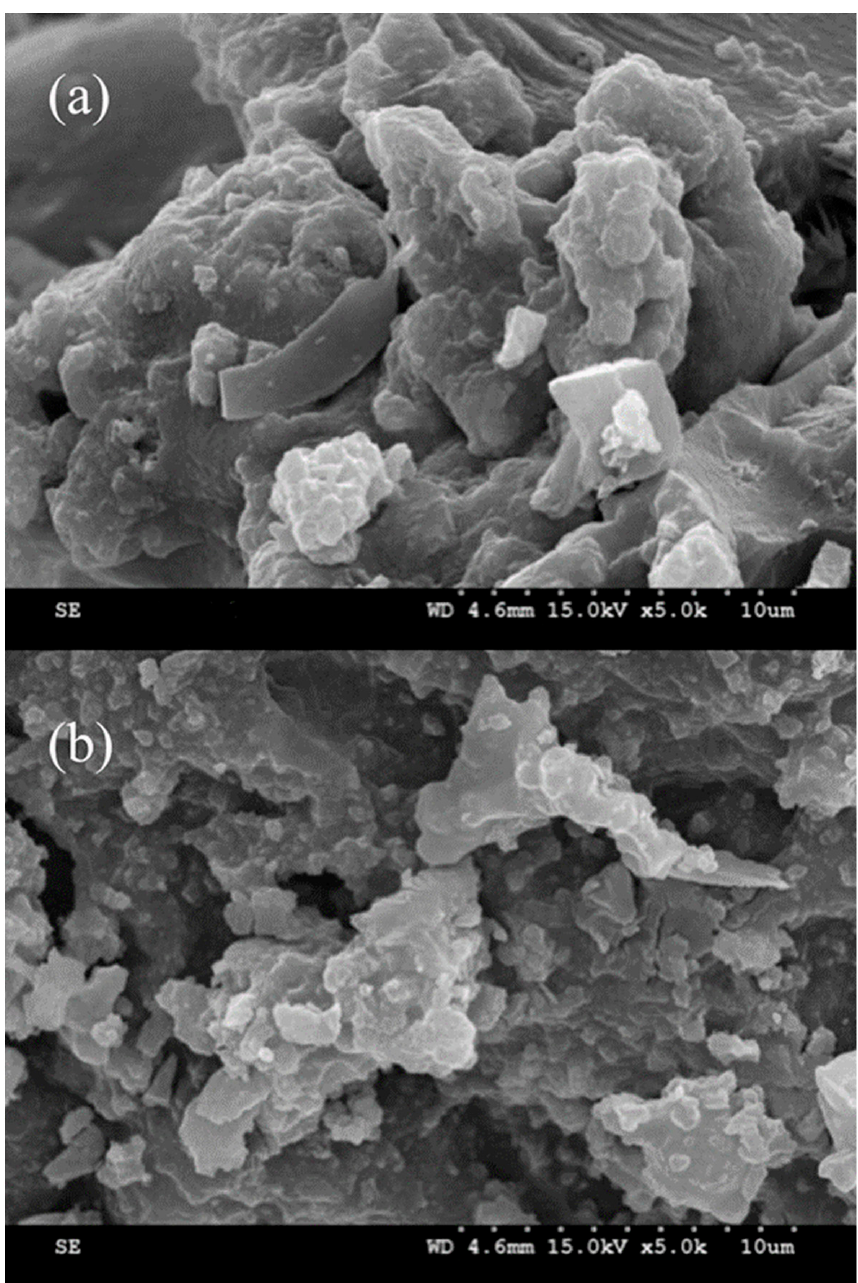
Figure 3. SEM images of the MNICM ( a ) and MMICM ( b ). TGA characterization of the MNICM and MMICM was also carried out, as shown in Figure S2. As can be seen, a first mass loss event was tested in the MMICM below 200 ◦ C, and in the MNICM at temperatures below 100 ◦ C, which corresponds to the evaporation of moisture. Then, MNICM started to lose weight significantly at around 100 ◦ C, and stabilized at 18.2% at 400 ◦ C. The temperature at which MMICM began to lose weight increased slightly at about 200 ◦ C, and finally stabilized at 34.8% at 500 ◦ C, indicating the improved thermal stability and increased imprinting groups of the MMICM. The BET from the N 2 adsorption–desorption assay and the mathematical treatments was used to determine the specific surface areas, pore size distribution, and the volume of MMICM and MNICM, as can be seen in Figure S3. It can be observed that, because of the N 2 adsorption on the larger mesopores, the adsorption isotherms of both materials increased rapidly